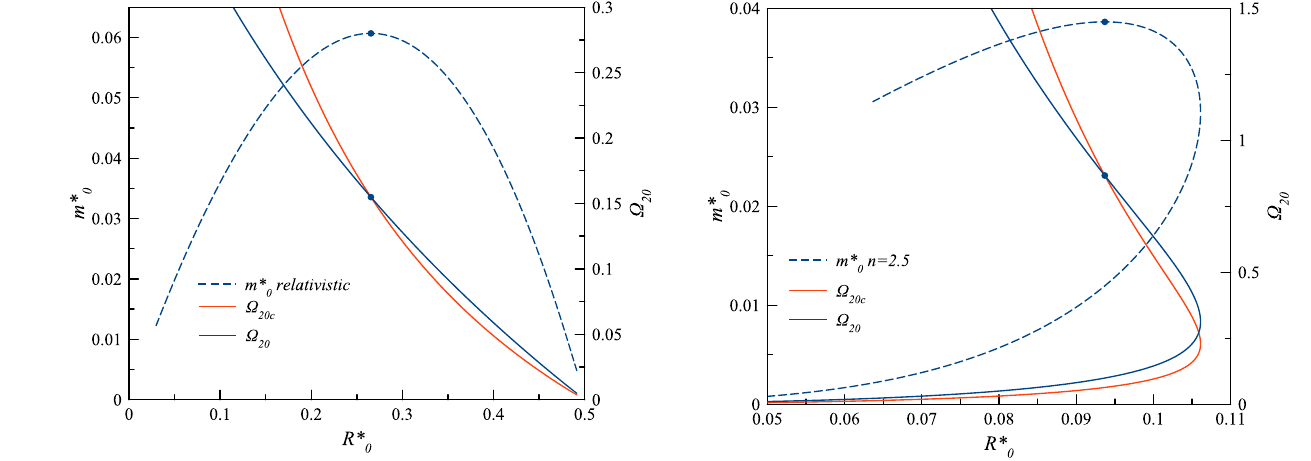
Fig. 2 The figure shows the m ∗ EOS defined by Eqs. (26) and (27), as well as the critical values of Ω 2 that follow from dynamical stability and those that follow from the EOS, in red and blue, respectively